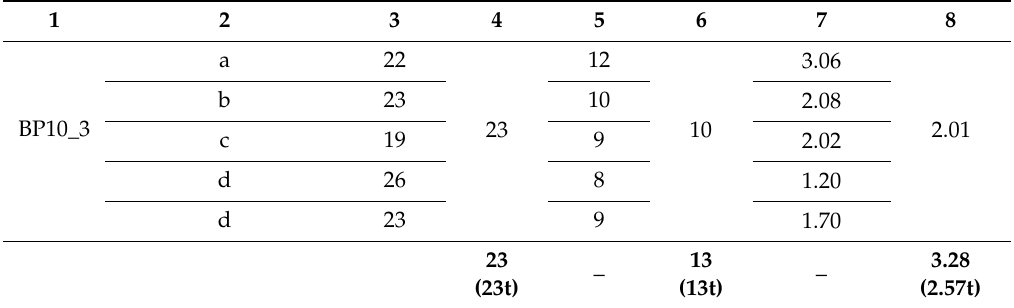
Figure 5. Relationship between the total force and mean displacement for test results and calculations.